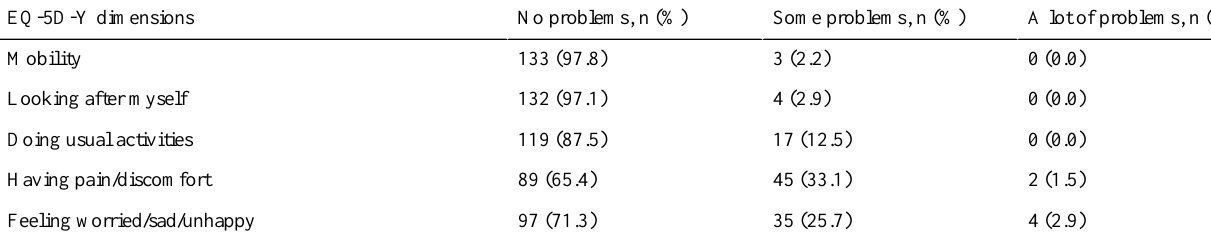
Table 2. Distribution of the EuroQol-5D-Youth (EQ-5D-Y) dimensions.